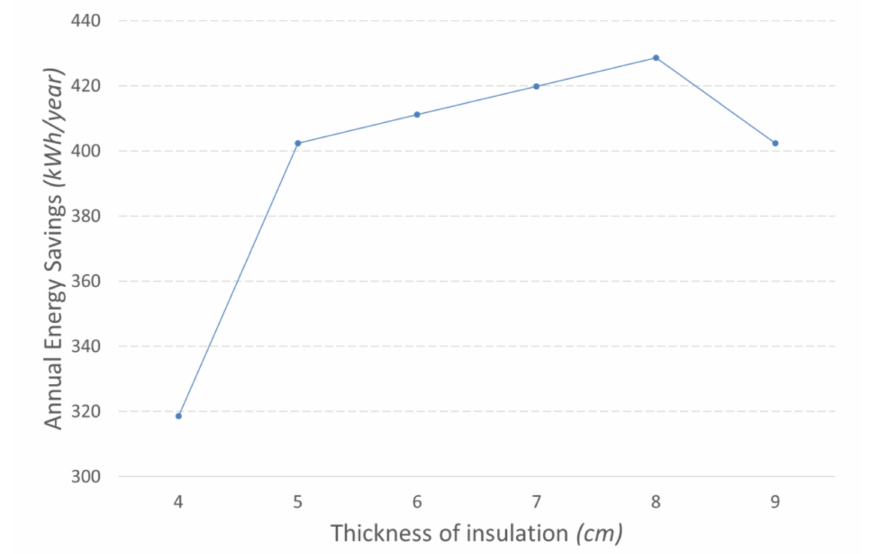
Figure 7. Annual energy savings against insulation thickness.